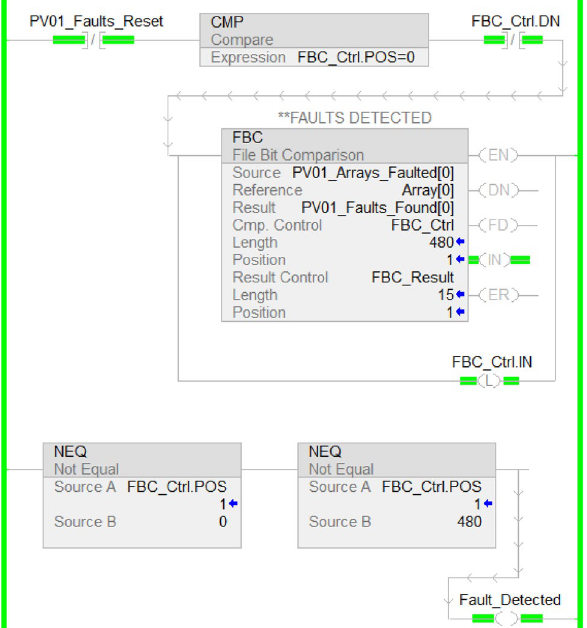
Fig. 6 Monitoring all PV01 related faults